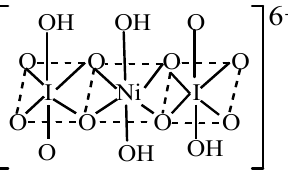
Figure 2. Chemical structure of [Ni(OH) 2 (HIO 6 ) 2 ] 6− complex anion.